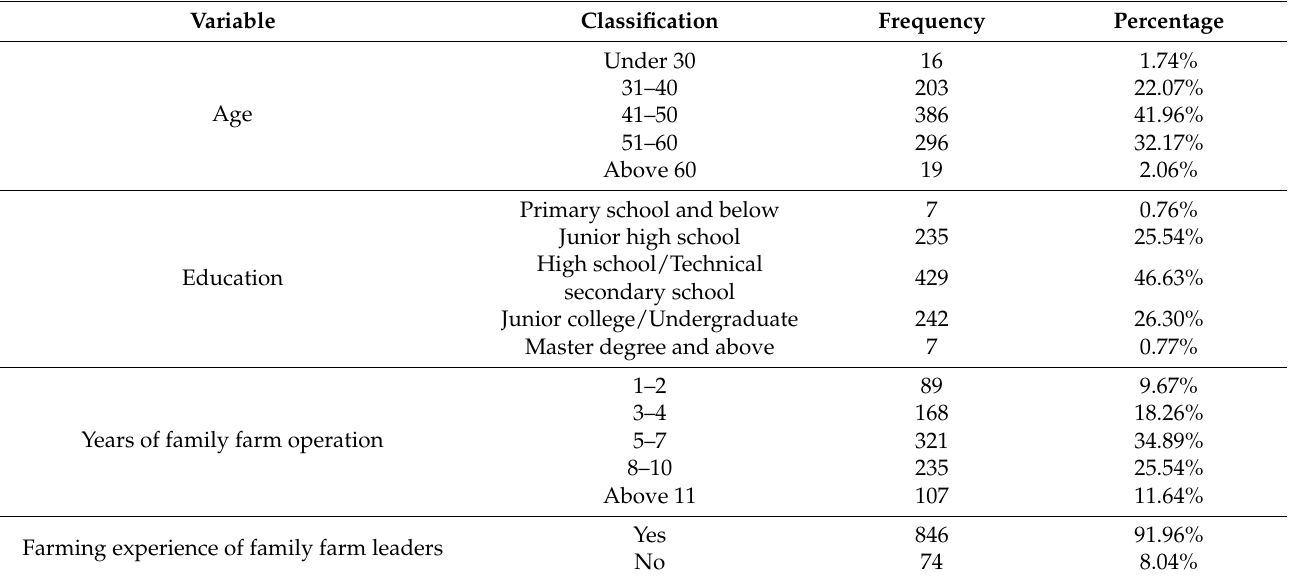
Table 1. Sample basic